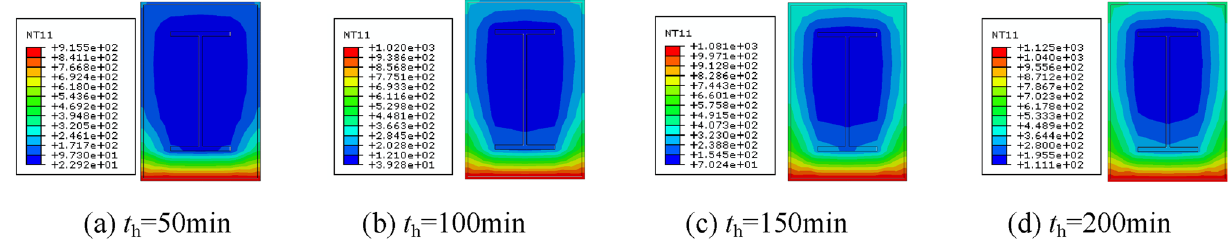
Figure 10. Cross-sectional temperature clouds at various stages of the fire on single surface.